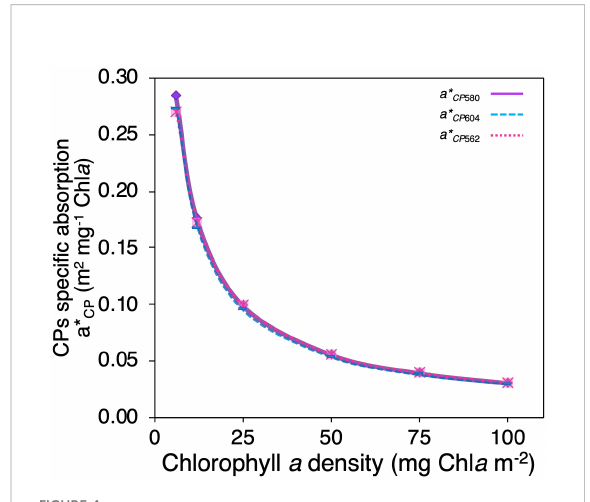
FIGURE 4 Comparison of changes in animal CP speci fi c absorption coef fi cient (a* CP ) as a function of Chl a density of “ colorful ” corals for the three animal CPs used in the numerical model asulCP562 (pink dotted line), amilCP580 (purple solid line), and amilCP604 (clear blue dashed